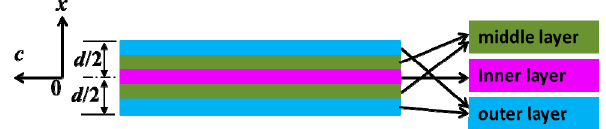
Figure 2. Schematic diagrams of: ( a ) The thermally stimulated depolarization current (TSDC) method and ( b ) the isothermal surface potential decay (ISPD) method.